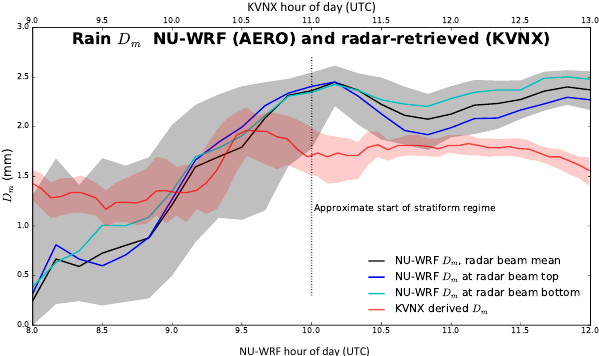
Figure 18. Mass-weighted mean diameter ( D m ) as a function of time in the AERO simulation and in retrievals averaged over the respective red-bounded geographic regions shown in Fig. 9. Lines indicate median values (see legend). Shaded regions indicate the inner half of retrieved values and simulated values at the radar beam mean height. Note the offset in time axes (top and bottom) to align approximate timing in observations versus